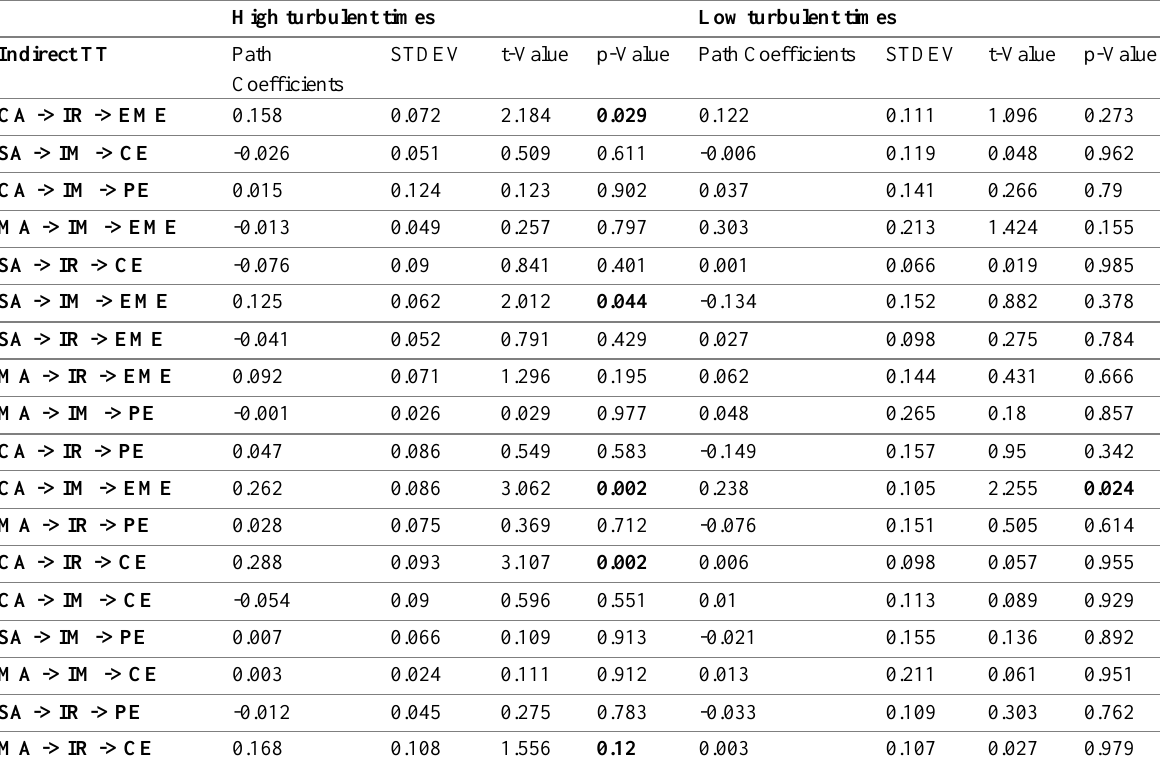
Table 10: Multi-group analysis for Turbulent times (indirect